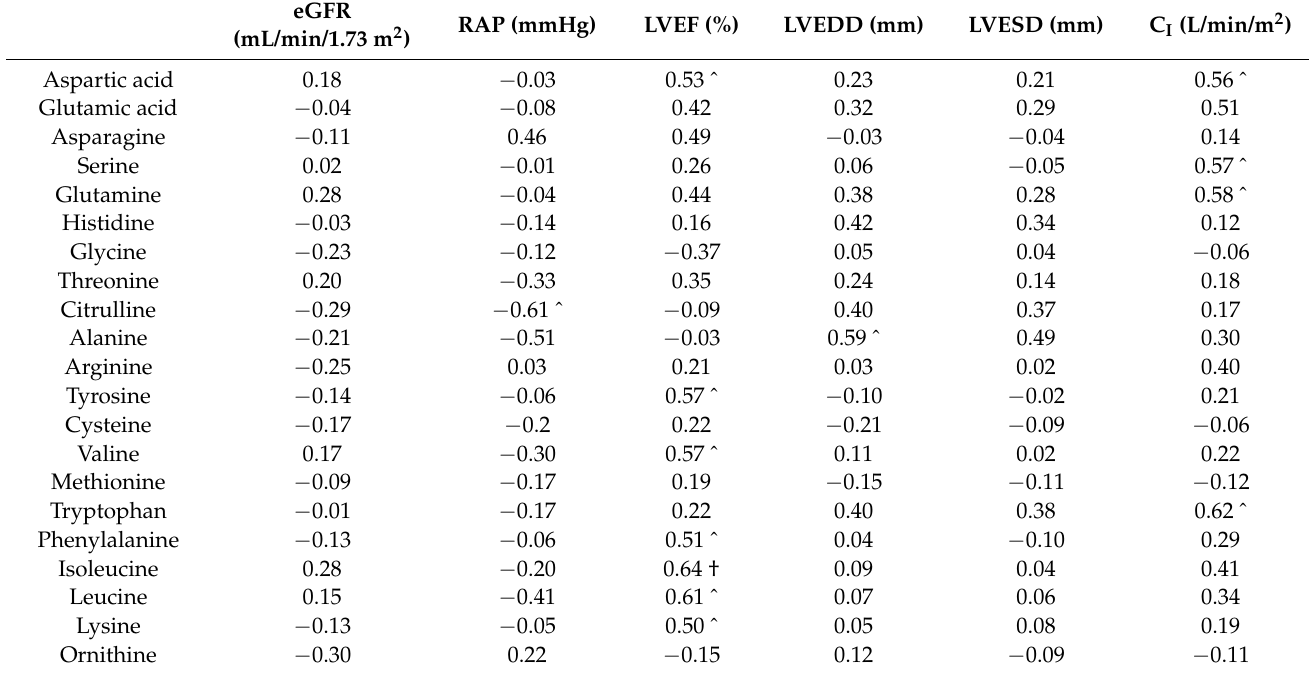
Table 10. Correlation coefficients (Spearman’s r ) between plasma arterial concentrations of individual AAs ( µ mol/L), and renal function and hemodynamic